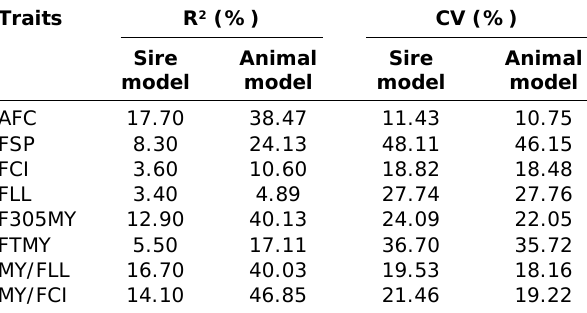
Table-3: Effectiveness of univariate sire evaluation models for prediction of BVs for first lactation traits, based on the R 2 and CV.